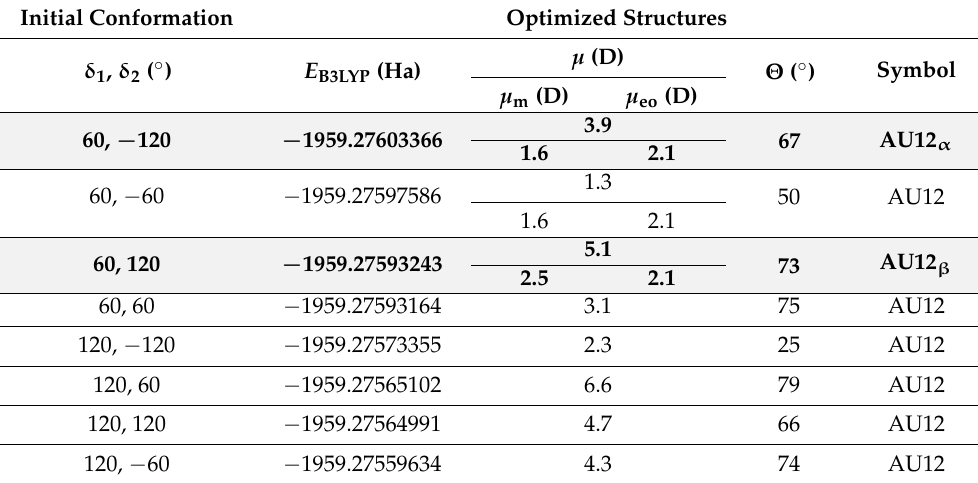
Table 2. Results of geometry optimization for AU12. The angles δ i describe the initial conformation. E is the B3LYP energy after optimization. Values of the dipole moment: µ —total, µ m— mesogen, µ eo— epoxy chain. Θ is the angle between the total dipole moment and the principal molecular axis. The two chosen conformations are highlighted.